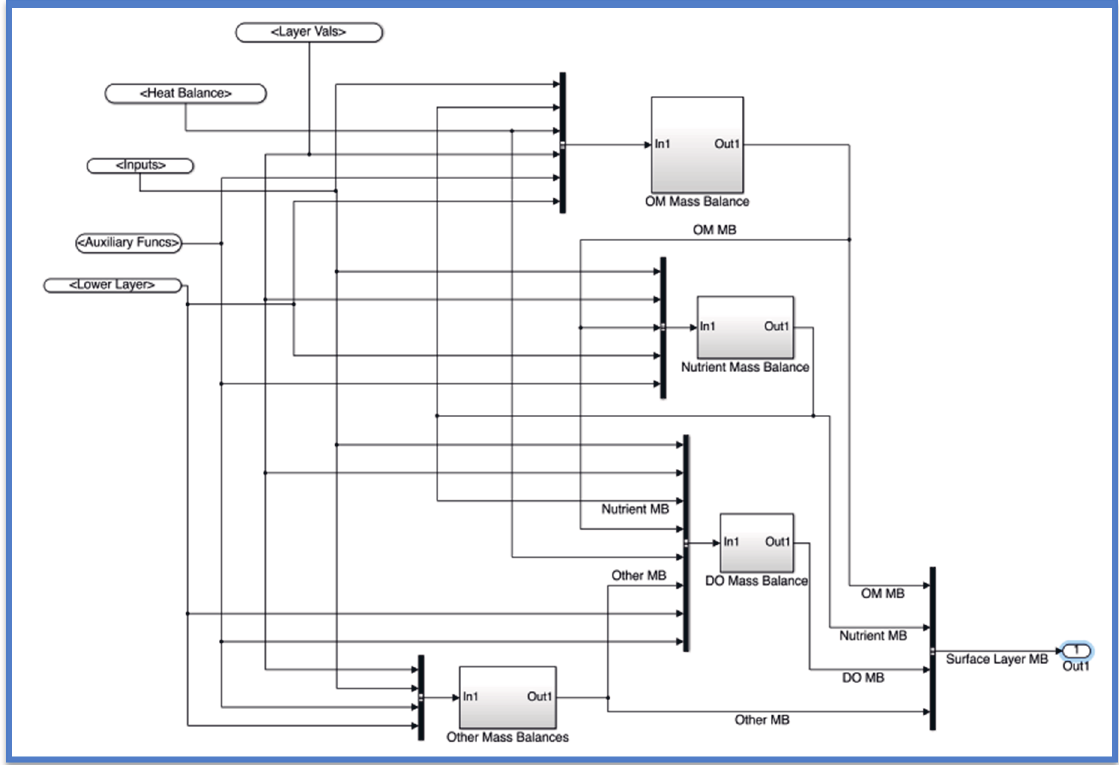
Figure 8. W2_SL model of the mass balances for the surface layer of segment 1 as implemented in Simulink. Separate subsystems (shown with boxes) calculate the organic matter, nutrient, dissolved oxygen and other mass balances for each the layer. Lines and arrows indicate data transfers between subsystems.